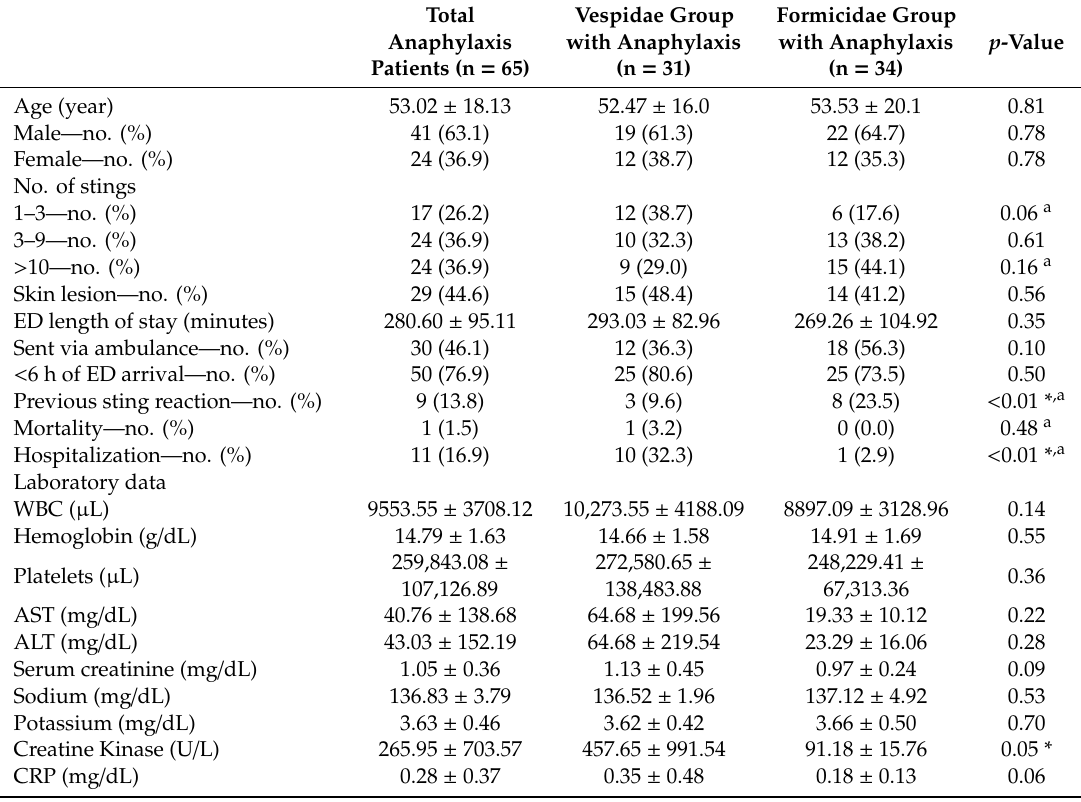
Table 4. Laboratory data for the two study groups with anaphylaxis.